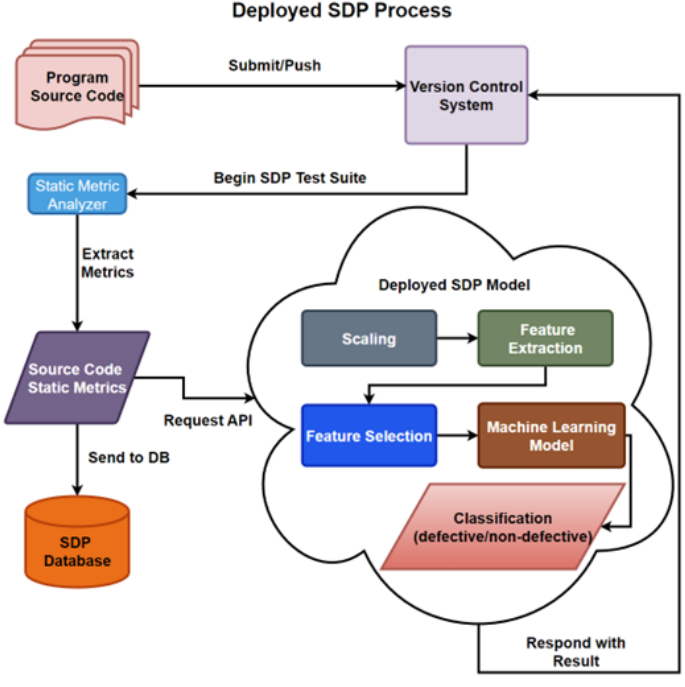
Figure 60. The Deployed SDP